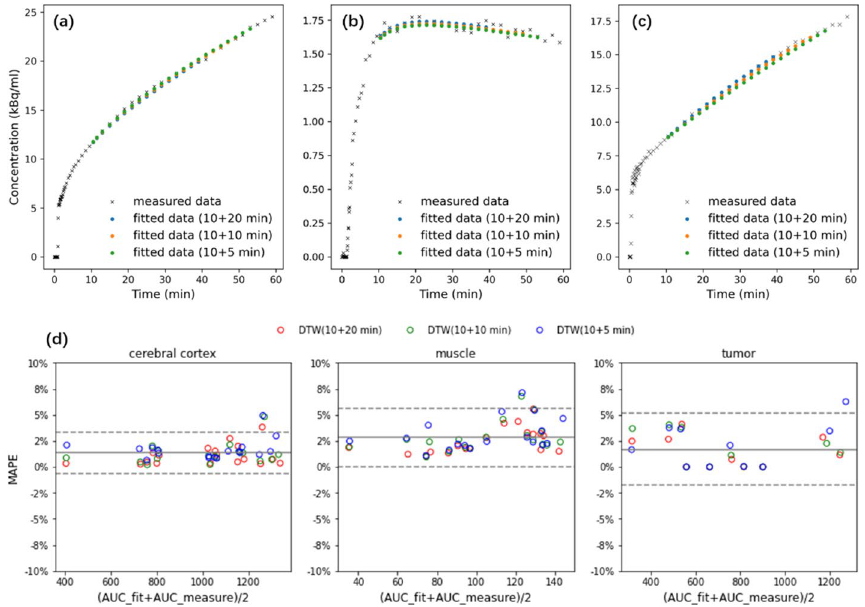
Fig. 3 For an example subject, nonlinear fitting of the missing data was performed using the 3rd degree rational function. a – c correspond to the TACs in the cerebral cortex, muscle, and tumor, respectively; d Bland–Altman plots of the MAPE (mean absolute percentage error, Eq. 12) in TAC estimation for each ROI with different scan